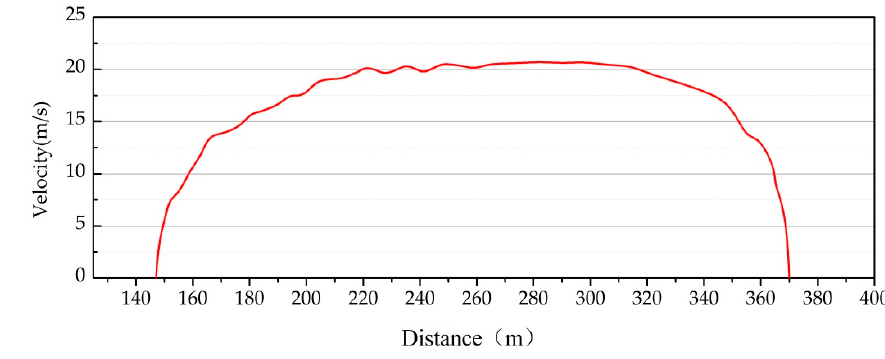
Figure 7. Variation of speed versus sliding range.